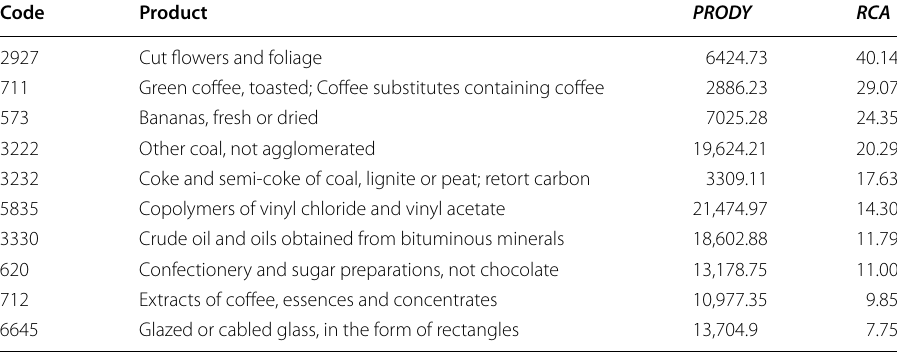
Table 5 Ten products in which Colombia has exporting power. Source : Author’s calcula- tions